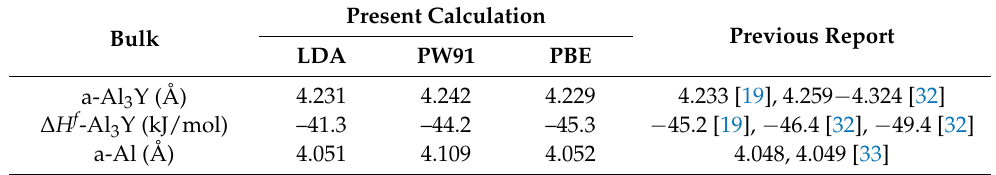
Present Calculation